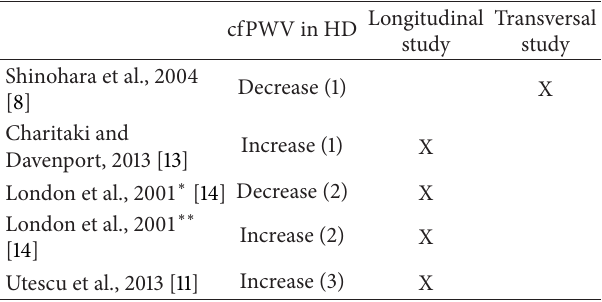
Table 1: Arterial (Aortic) stiffness in hemodialyzed patients. Longitudinal cfPWV in HD study